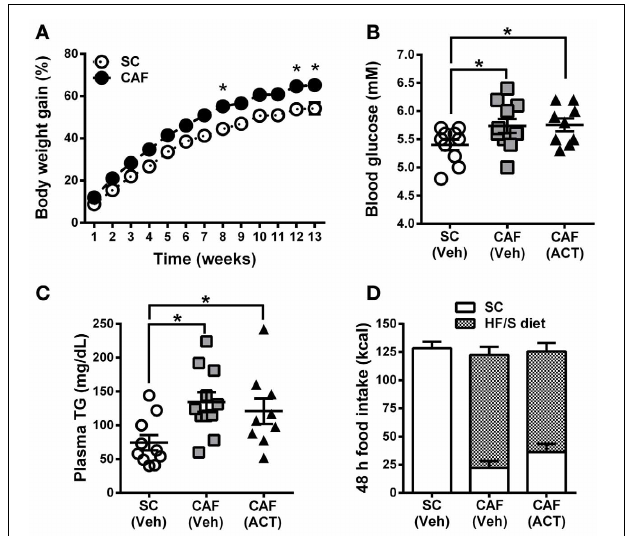
FIGURE 2 | Weight gain, MetS and food intake before treatment onset. (A) Time course of body weight gain over 13 weeks of SC and CAF diet feeding. Body weight gain is expressed as the percentage change from baseline body weight at the start of diet exposure. Mean ± s.e.m. (SC n = 10; CAF n = 20). ∗ p < 0 . 05 vs. SC at the indicated time point by post-hoc test following ANOVA. Levels of whole blood glucose (B) , and of plasma triglycerides (TG) (C) were analyzed in week 11 and 13, respectively. The group of 20 CAF diet fed rats was subdivided into one Veh ( n = 11) and one ACT ( n = 9) group which were going to start receiving treatment (Veh and ACT indicated in brackets) in week 14. Horizontal bars represent the mean ± s.e.m. ∗ p < 0 . 05 by t -test. (D) Energy intake and food